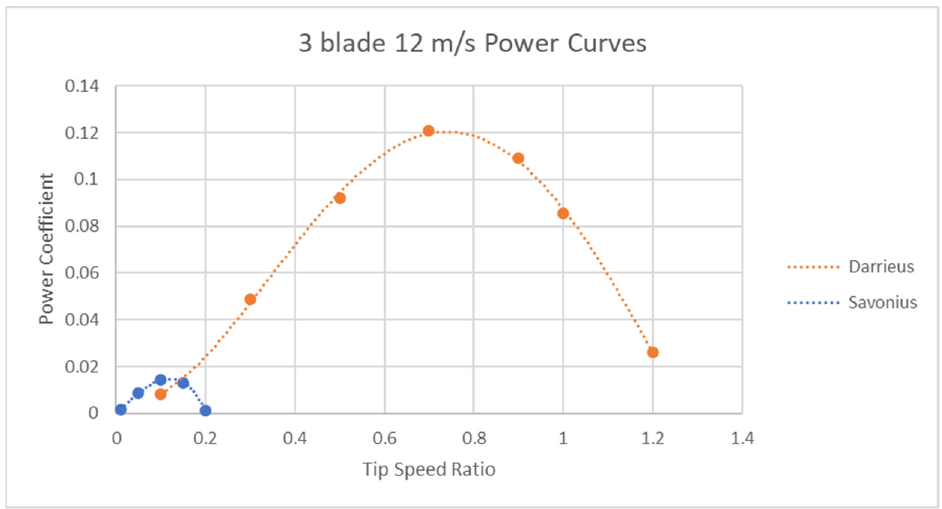
Figure 15. Darrieus and Savonius comparison.